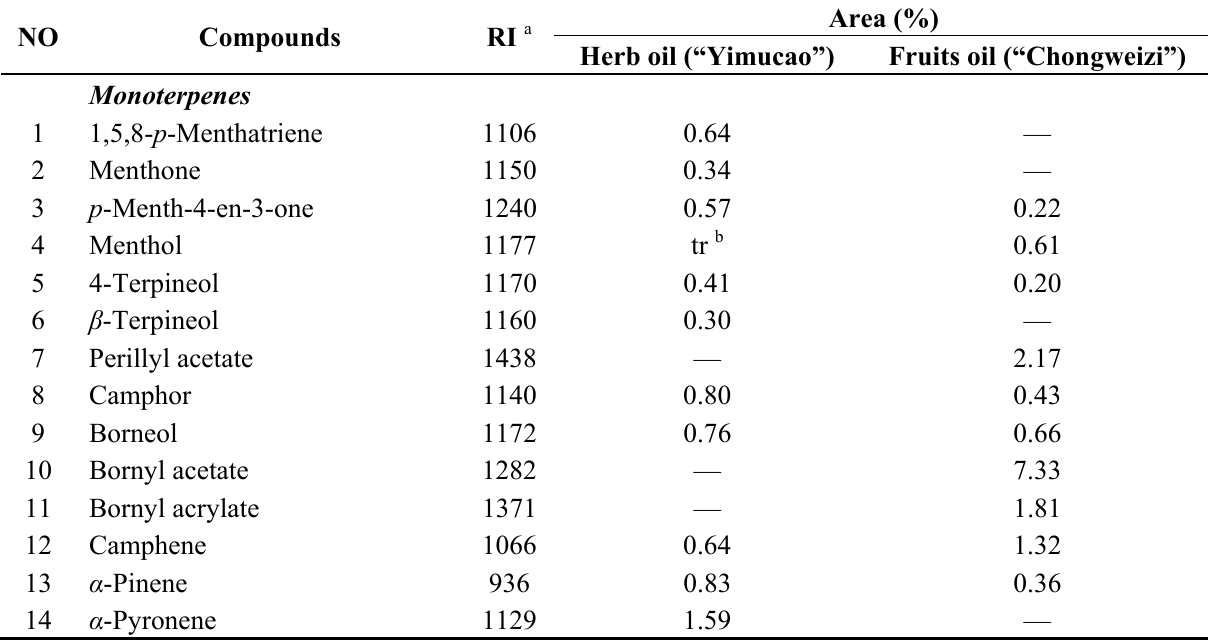
Table 2. Chemical composition of “Yimucao oil” and “Chongweizi